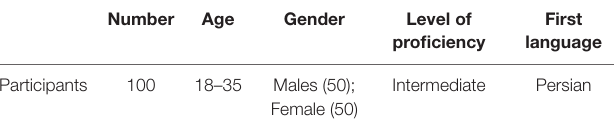
TABLE 1 | Demographic characteristics of the